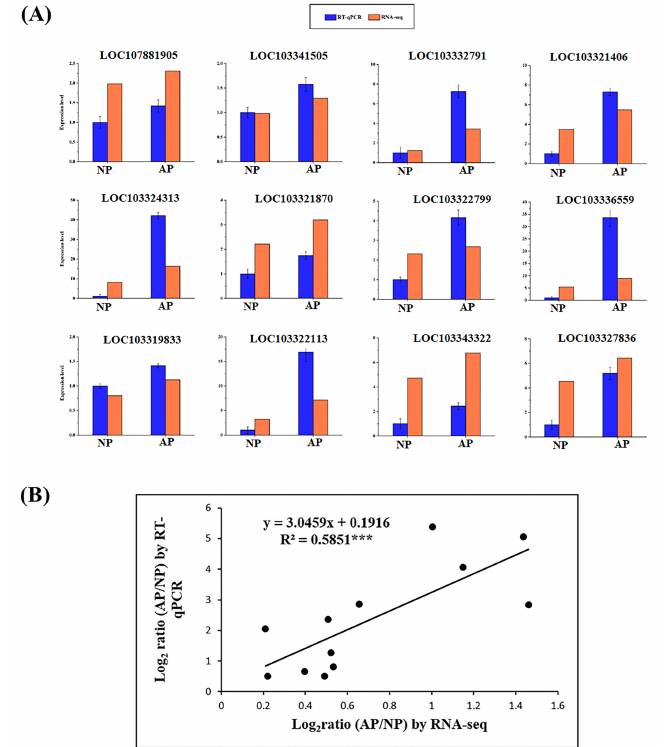
Figure 6. Validation of RNA-Seq data. ( A ) Verification of the expression level of the selected DEGs Schemes follow the same formatting. If there are multiple panels, they should be listed as: ( a ) Description of what is contained in the first Figure 4. This is a figure, from RNA-Seq data through RT-qPCR. Error bars indicate the standard error as mean + SD. The x-axis panel. ( b ) Description of what is contained in the second panel. Figures should be placed in the main text near to the first time they are cited. A caption on a single line represents the relative expression level, and the y-axis represents NP (normal pistils) and AP (abortive should be centered. pistils). ( B ) Correlation coe ffi cient of gene expression obtained from RT-qPCR analysis. *** shows highly significant level of the